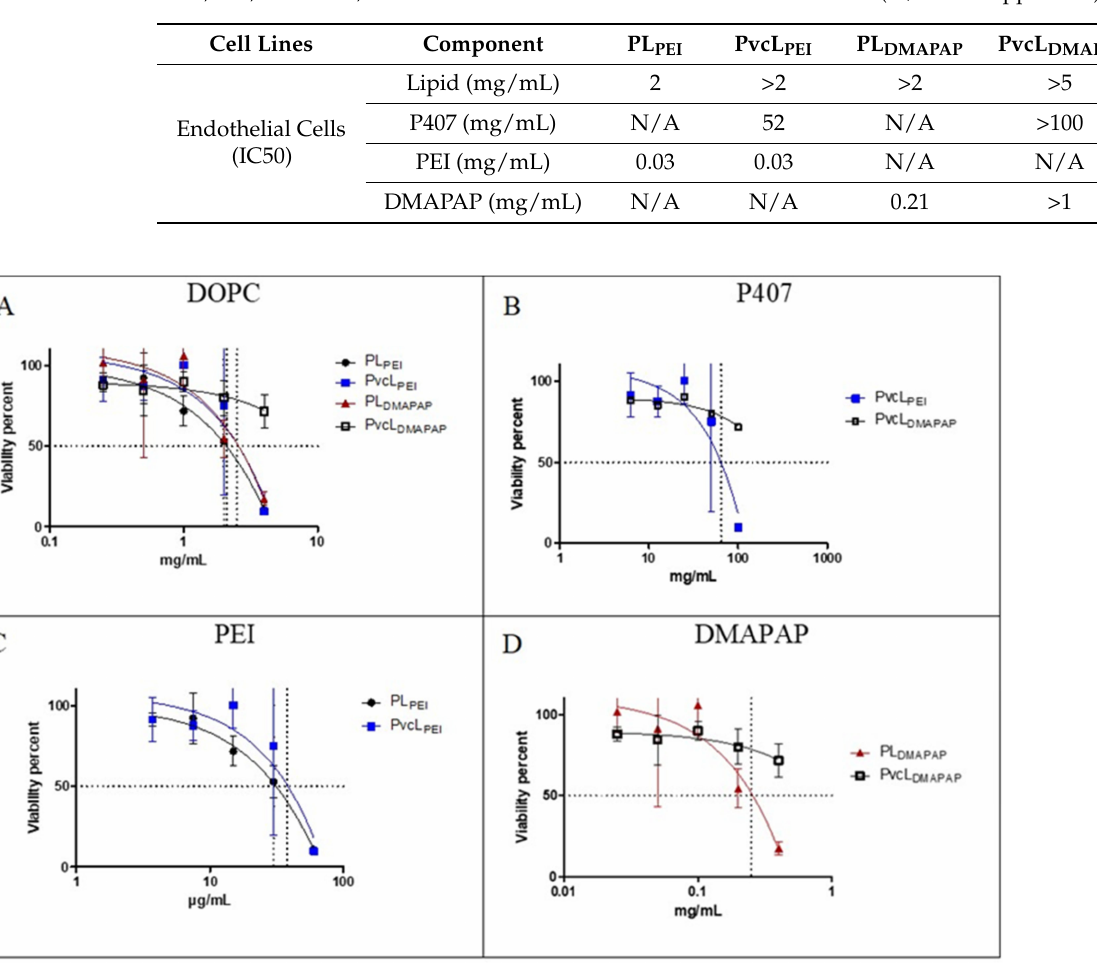
Table 4. The mean inhibition concentration 50 (IC50) values for EA.hy926 cells as a function of lipid,